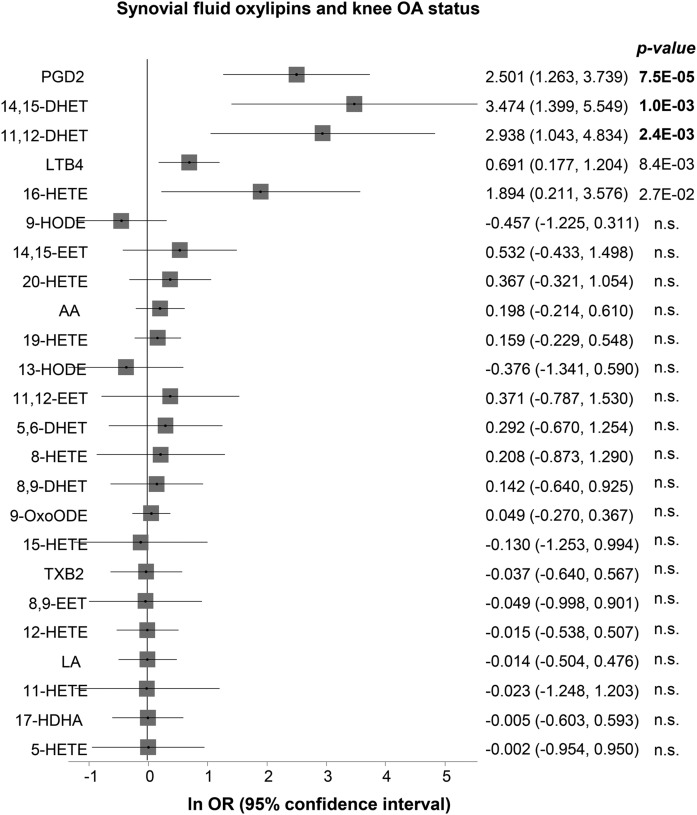
Forest plot showing the logistic regression coefficient (natural logarithm of the odds ratio) adjusted for age, sex, BMI, and use of NSAIDs. The effect is per log10 concentration unit as listed in Table 1.